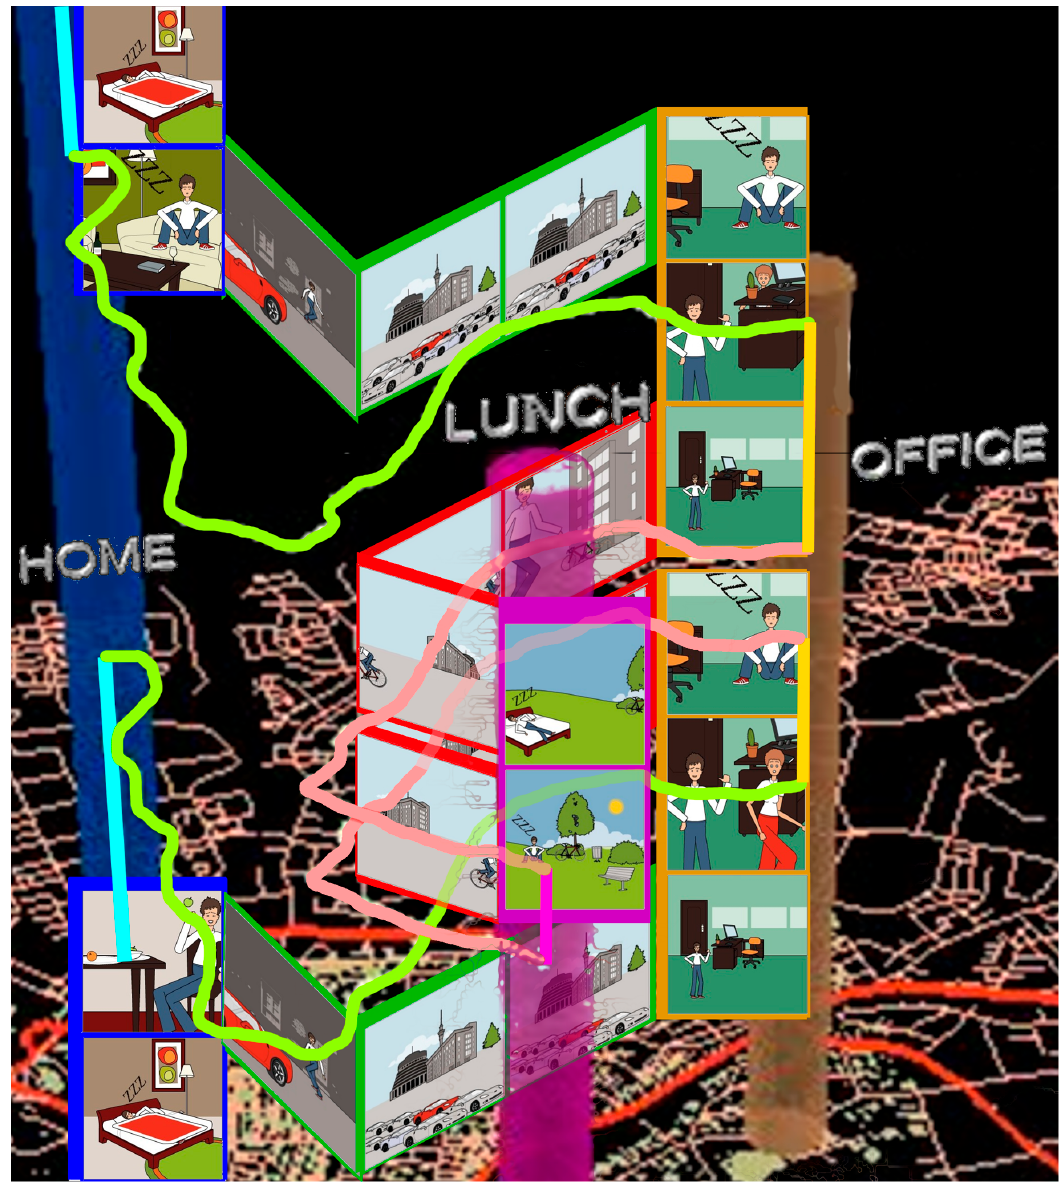
Figure 3. The comic strip embedded in a 3D time geography map (map from [59]).